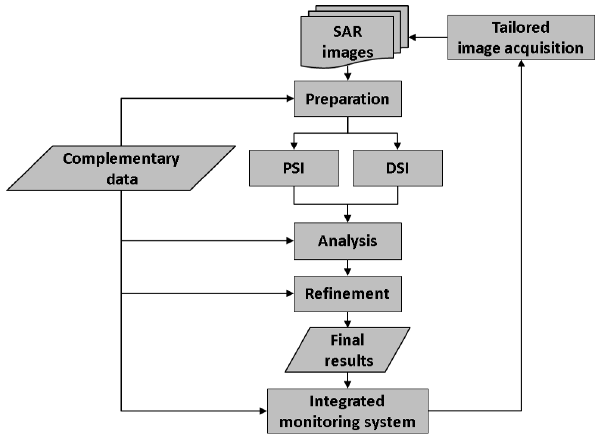
Figure 1. InSAR-based monitoring scheme.